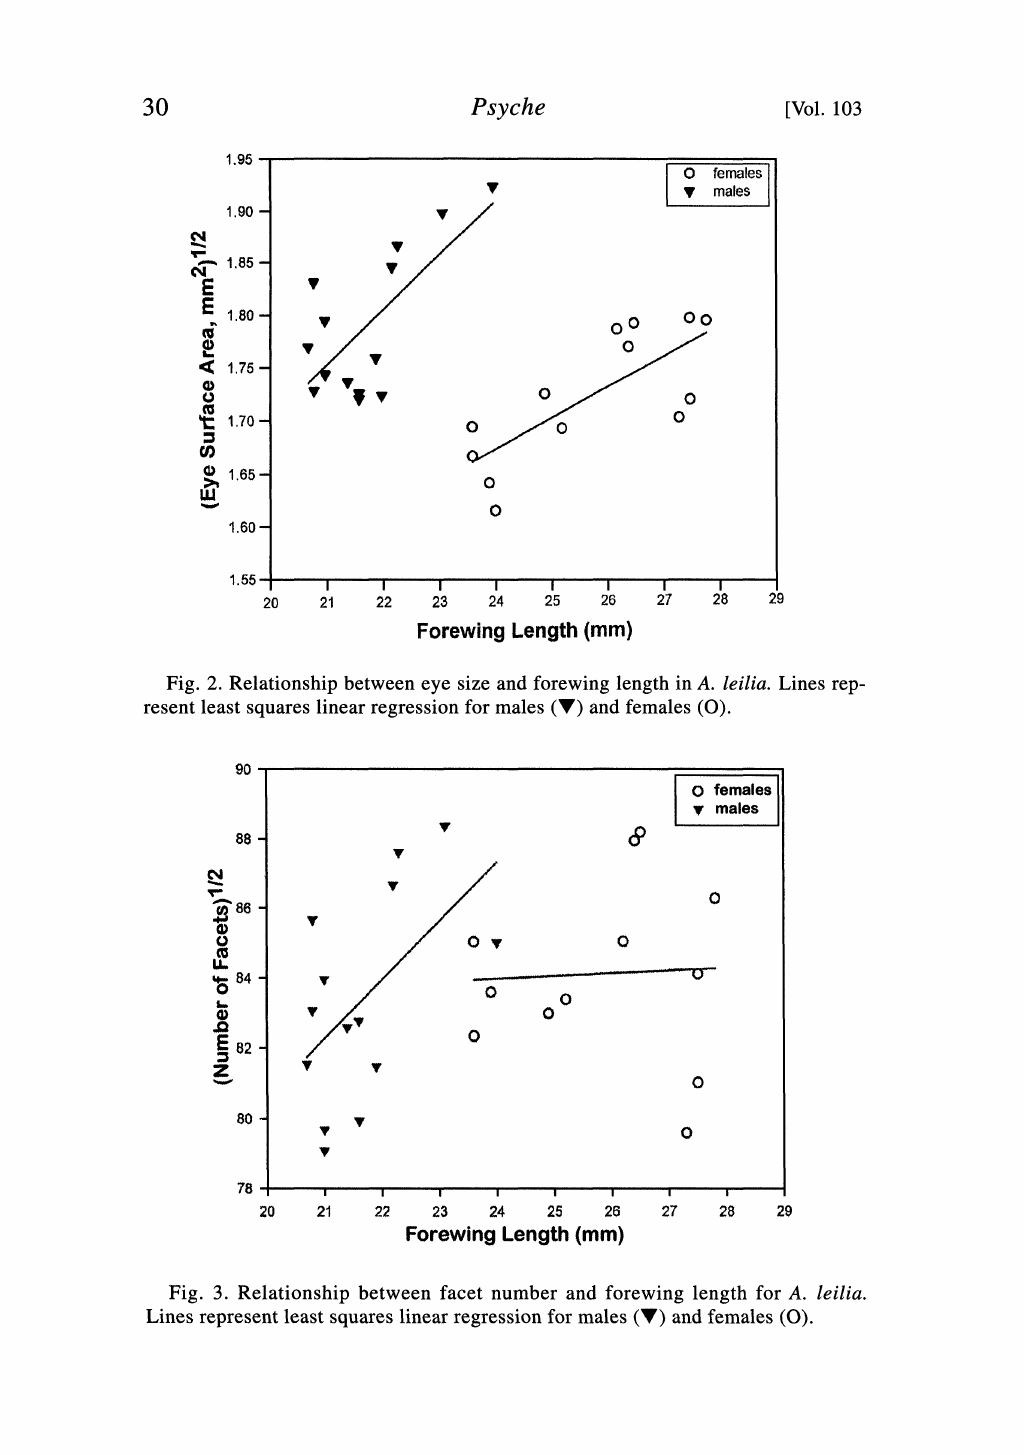
Fig. 3. Relationship between facet number and forewing length for A. leilia. Lines represent least squares linear regression for males (’) and females